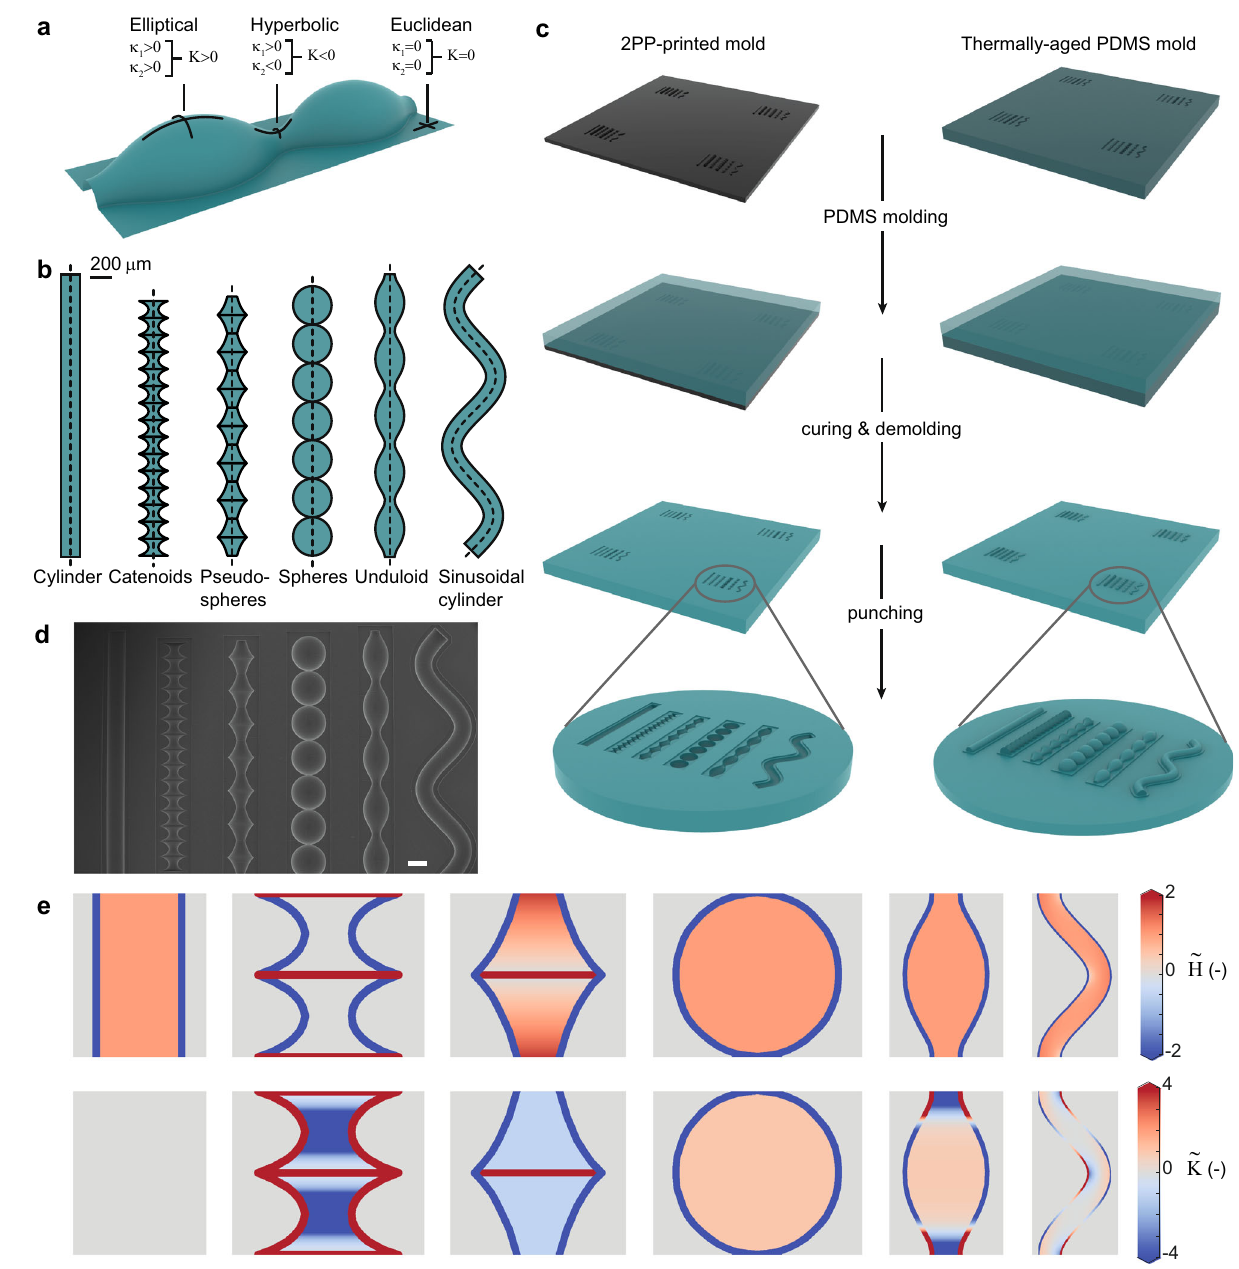
Fig. 1 | Design and microfabrication of curved cell substrates. a Local surface geometryde fi ned in terms of the principal curvatures, κ 1 and κ 2 , and the Gaussian curvature, K . b Thesurfacepro fi les(topview)usedtodesigncurvedcellsubstrates. The fi rst fi vesurfacesaresurfacesofrevolution(thedottedlineistherotationaxis), while the last surface is obtained by sweeping a circle along a sinusoidal path (dotted line). c Schematic of the fabrication of the PDMS substrates with curved imprints (concave, left column) or protrusions (convex, right column). The illus- tration is not shown to scale. d SEM image of a PDMS sample with imprinted